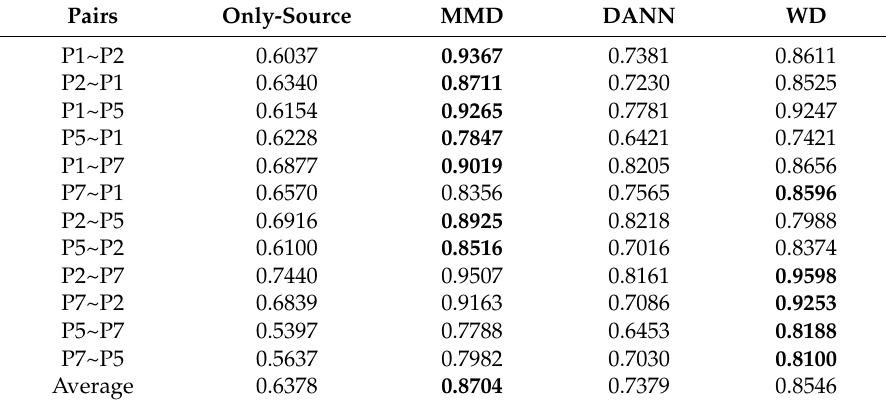
Table 4. The first round of experiment results of UCI. In this table, we show the accuracy of four cross-validation used, each data in the table is the mean value of three experiments. The bold number is the best result for the experiments in the same